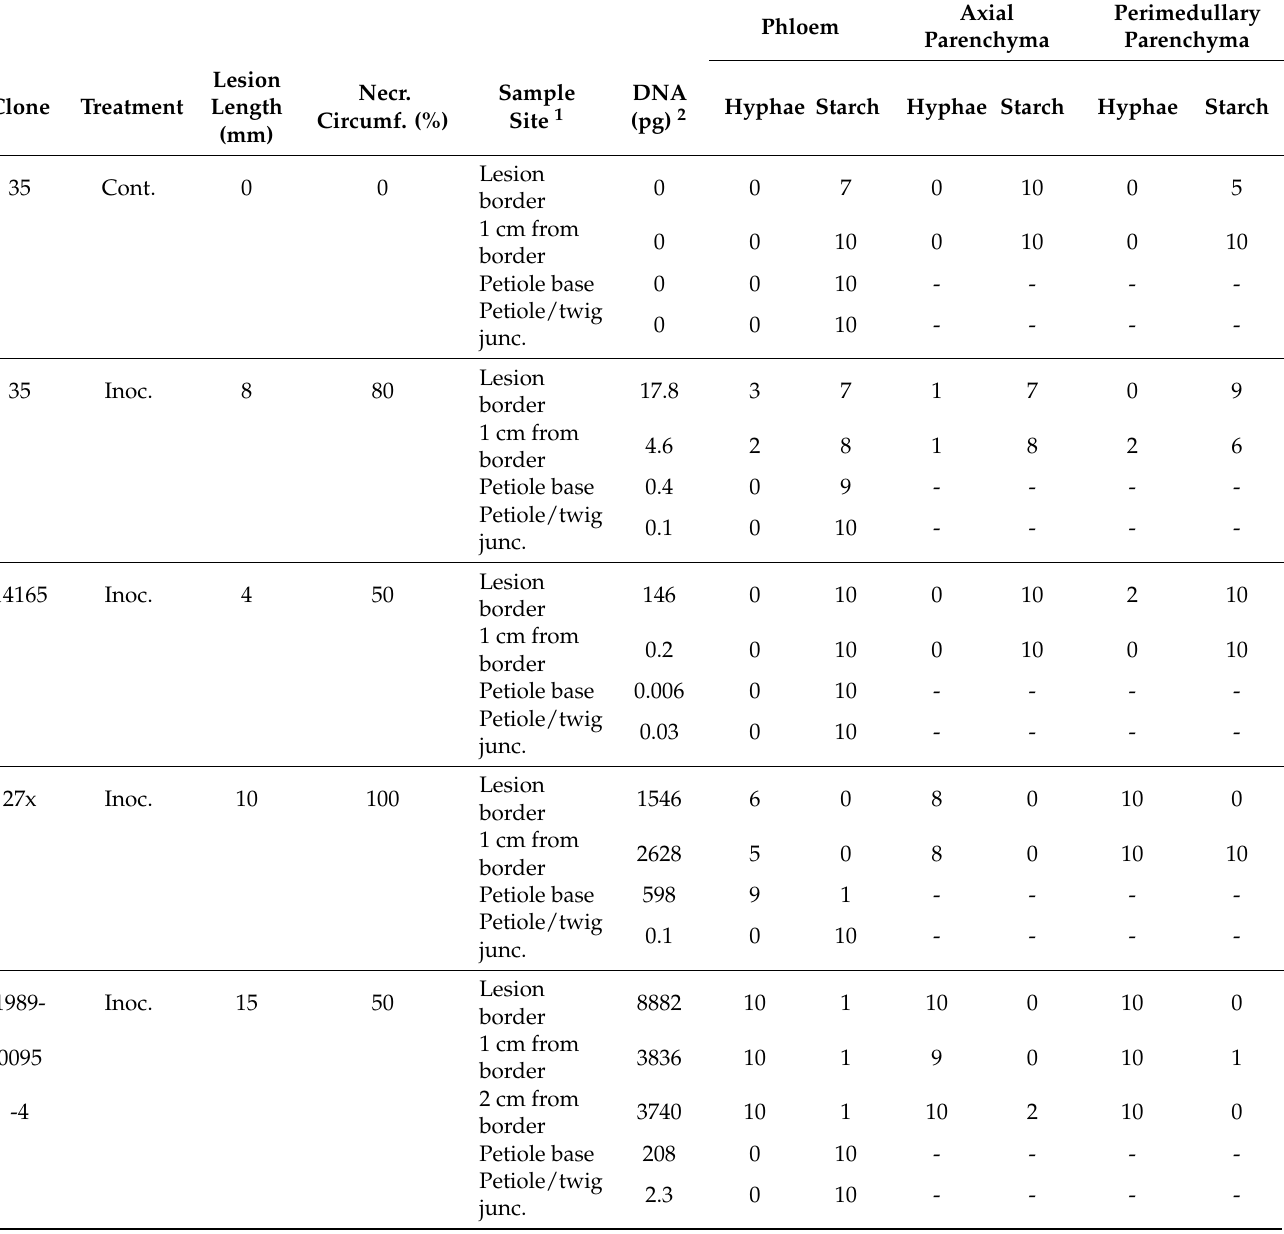
Table 2. Summary of the degree of necrotic tissue, level of pathogen DNA, and histological obser- vations of hyphal abundance and prevalence of starch from samples of four clones subjected to rachis-inoculation by Hymenoscyphus fraxineus and one clone inoculated with sterile plugs (Control). Ash dieback susceptibility in field: less susceptible; common ash clones 35, 14165 and Manchurian ash clone 1989-0095-4 and susceptible; common ash clone